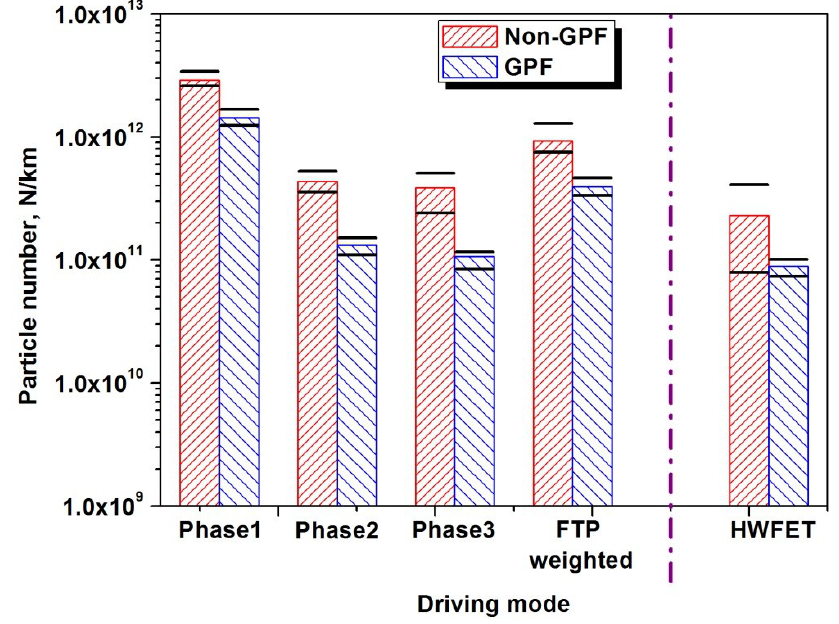
Figure 7. Comparison of particle number emissions by CPC of each phase of FTP-75 and HWFET